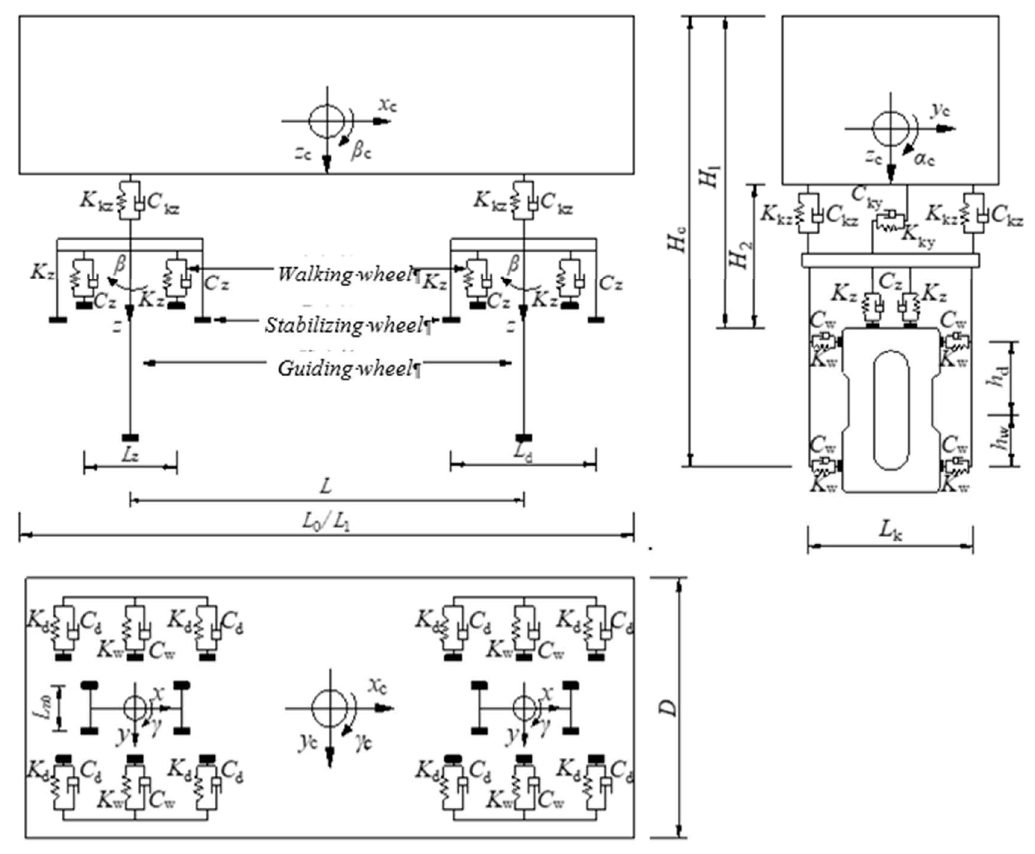
Figure 1. Dynamics analysis model of a straddle-type monorail.